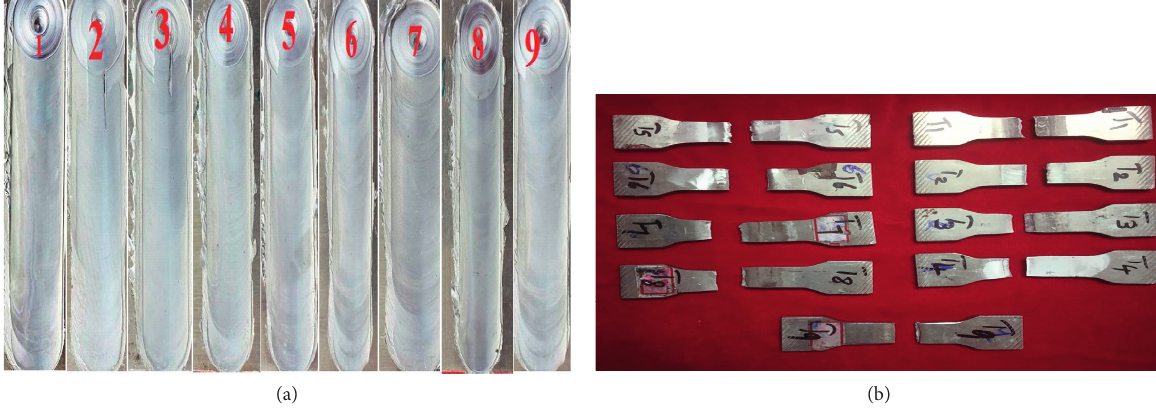
Figure 2: (a) Friction stir processed image and (b) prepared tensile